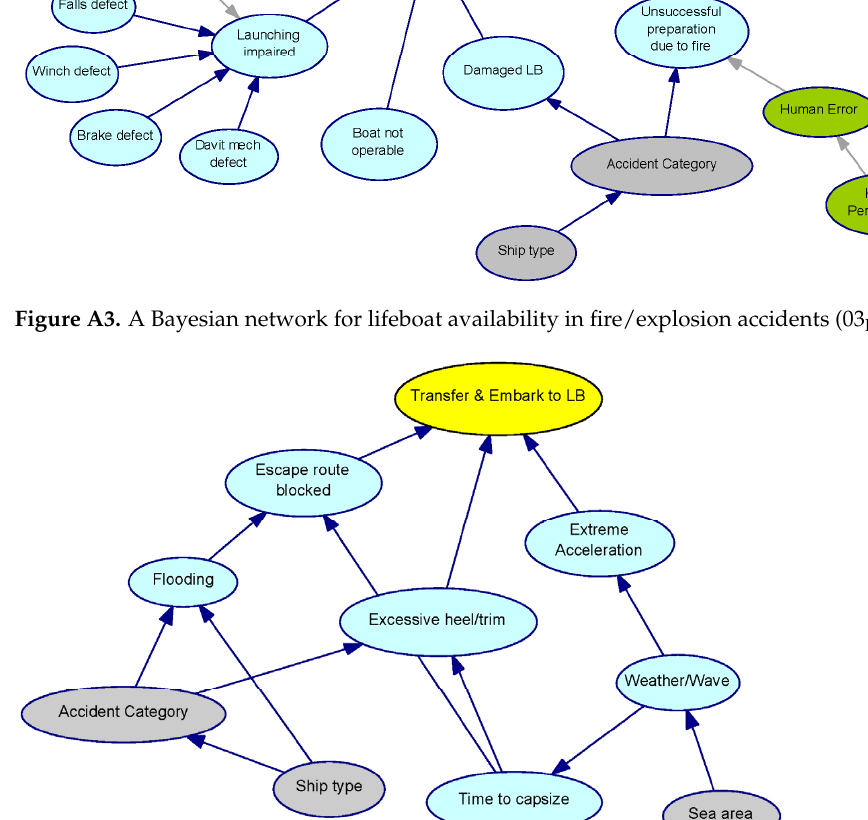
Figure A4. A Bayesian network for transfer and embarkation to lifeboats in flooding accidents